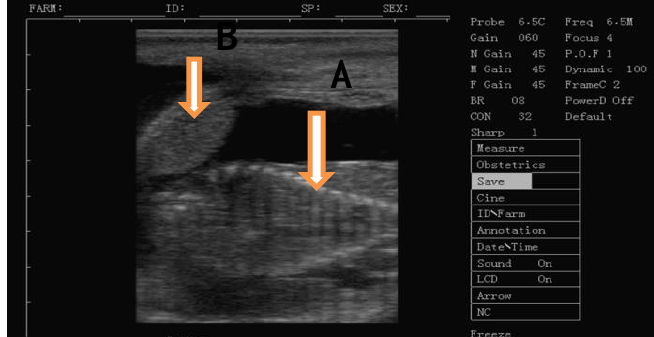
Figure 3. A: Buffalo fetus in the 3rd month shows fetal ribs ,B: